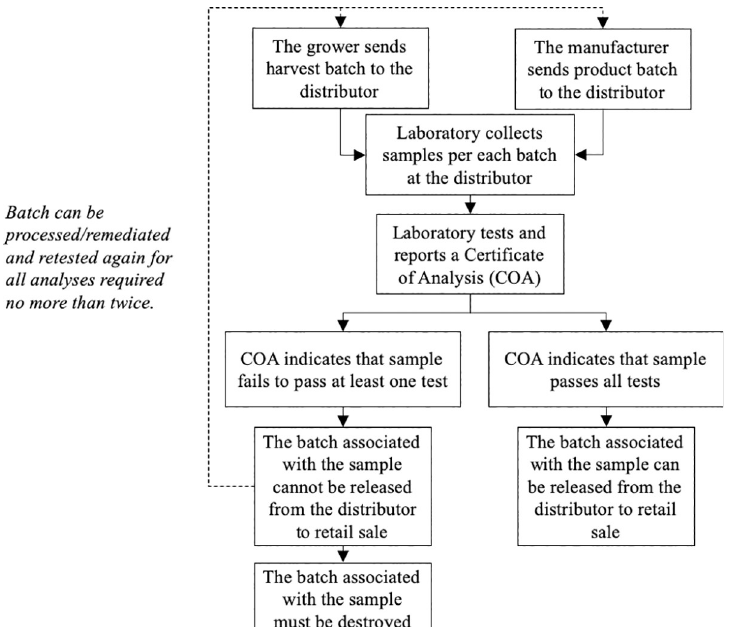
Fig 1. California’s cannabis testing